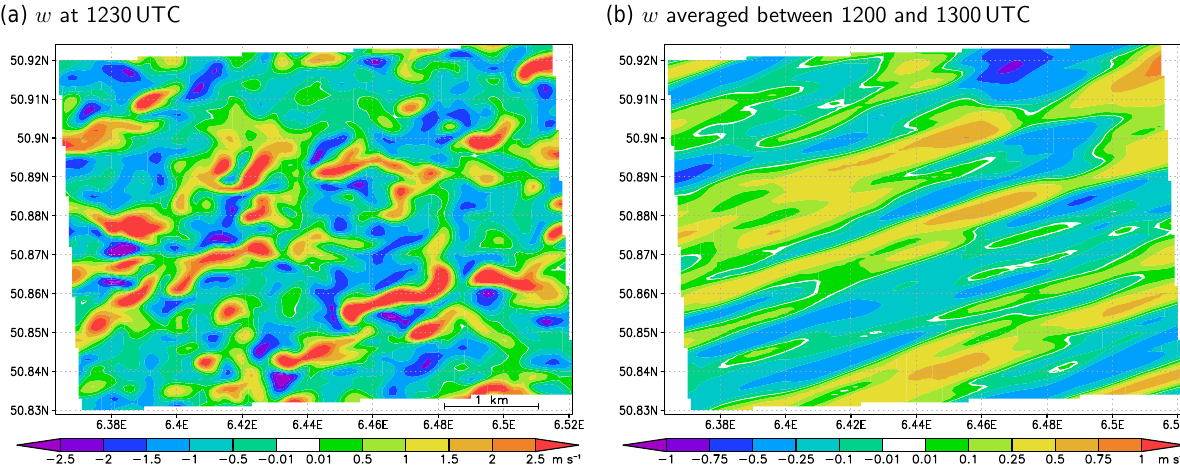
Figure 16. Vertical velocity at 600m on 24 April 2013 from LES model output: (a) instantaneous, (b) averaged field.